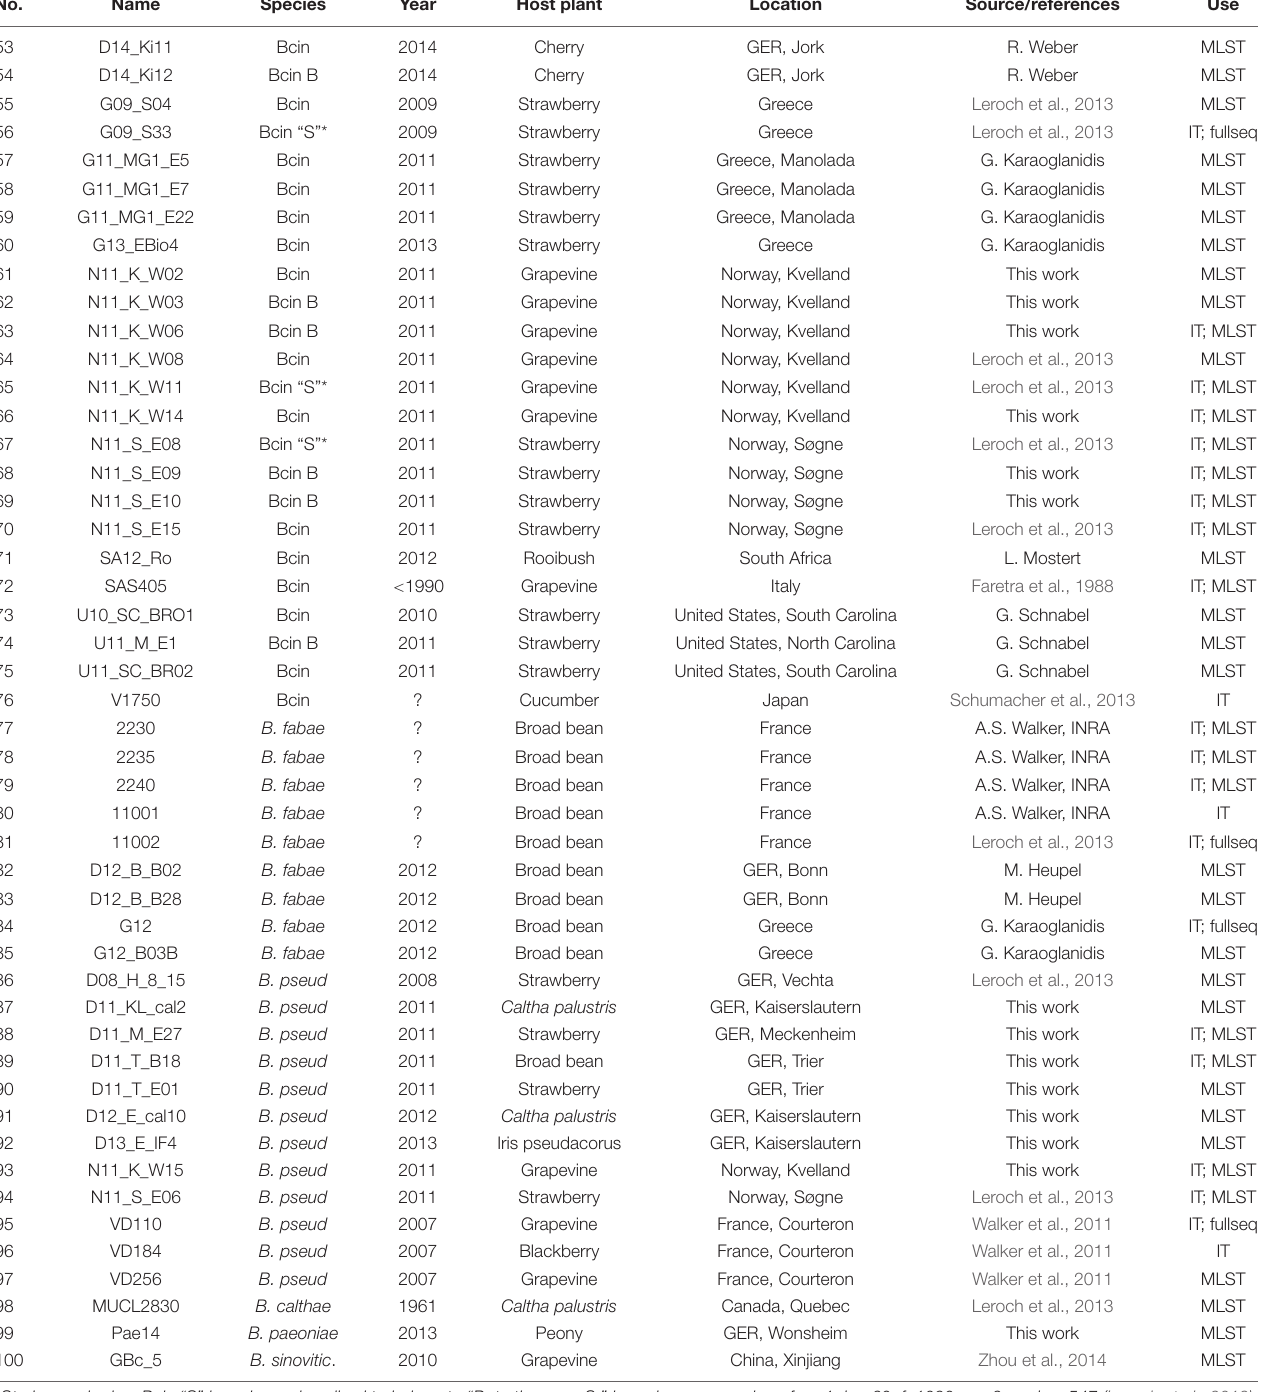
and a 21 bp indel in the mrr1 coding region showing variable configuration in different B. cinerea isolates (Leroch et al., 2013) allowed differentiation within B. cinerea (cf. Table 4